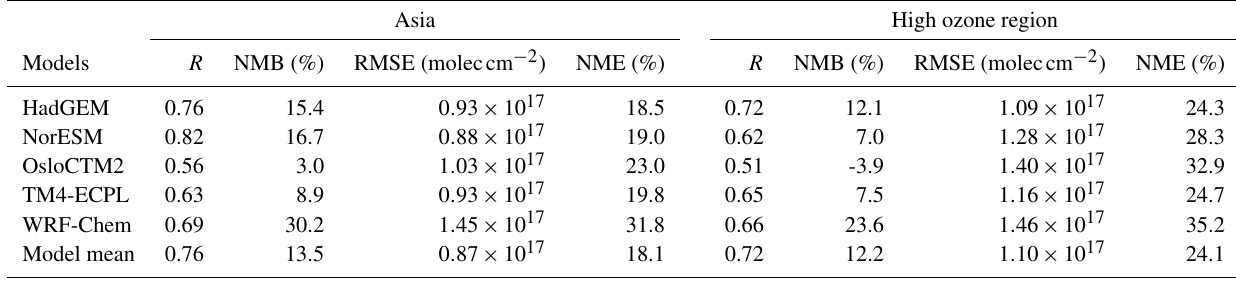
Table 3. Statistical parameters (correlation coefficient R , normalized mean bias NMB, root mean square error RMSE and normalized mean error NME) based on spatial variations calculated using simulations of the 0–6km ozone columns over Asia (left parameters) and over the high concentration columns delimited in black in Fig. 2 (right parameters) in August 2008 by the ECLIPSE models compared to the IASI ozone FORLI observations.